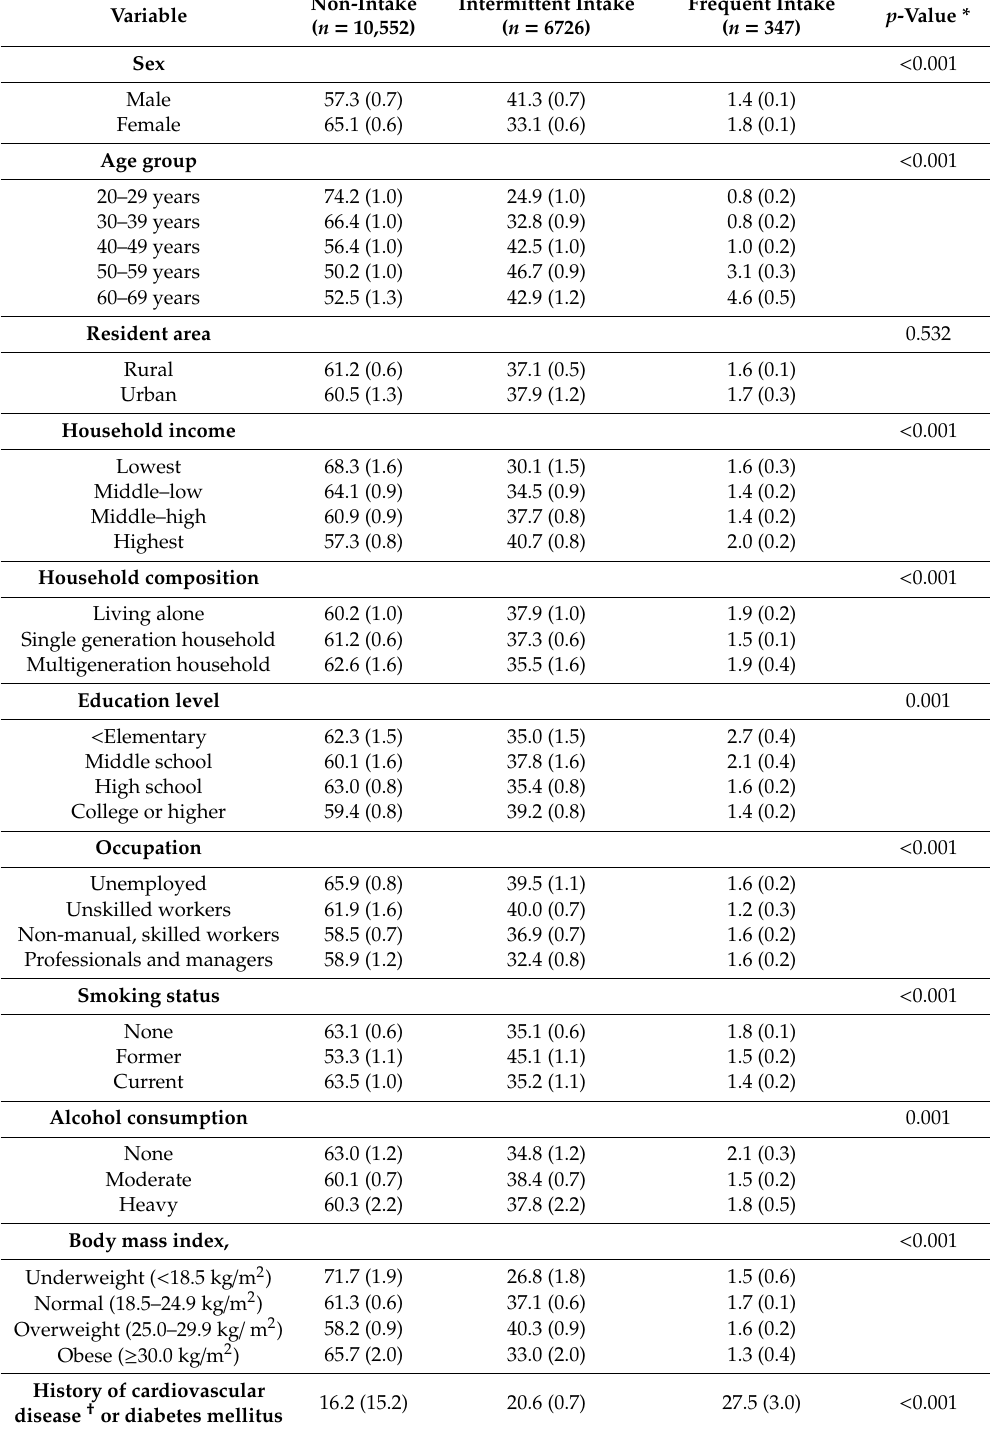
Table 1. Sociodemographic characteristics of study participants according to frequency of peanut consumption. ( n =